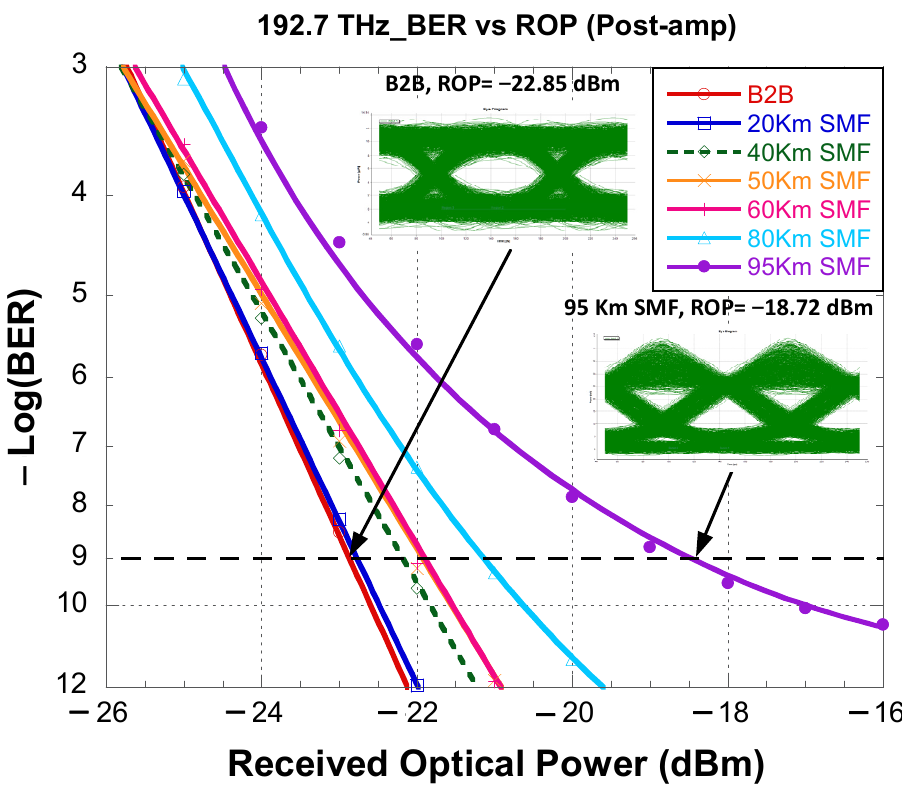
Figure 16. BER curve of CH20 (192.7 THz).